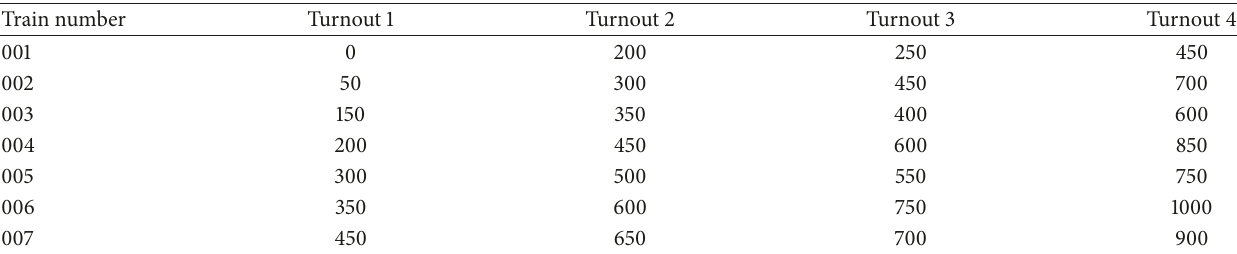
Table 1: The preset timetables of the trains.